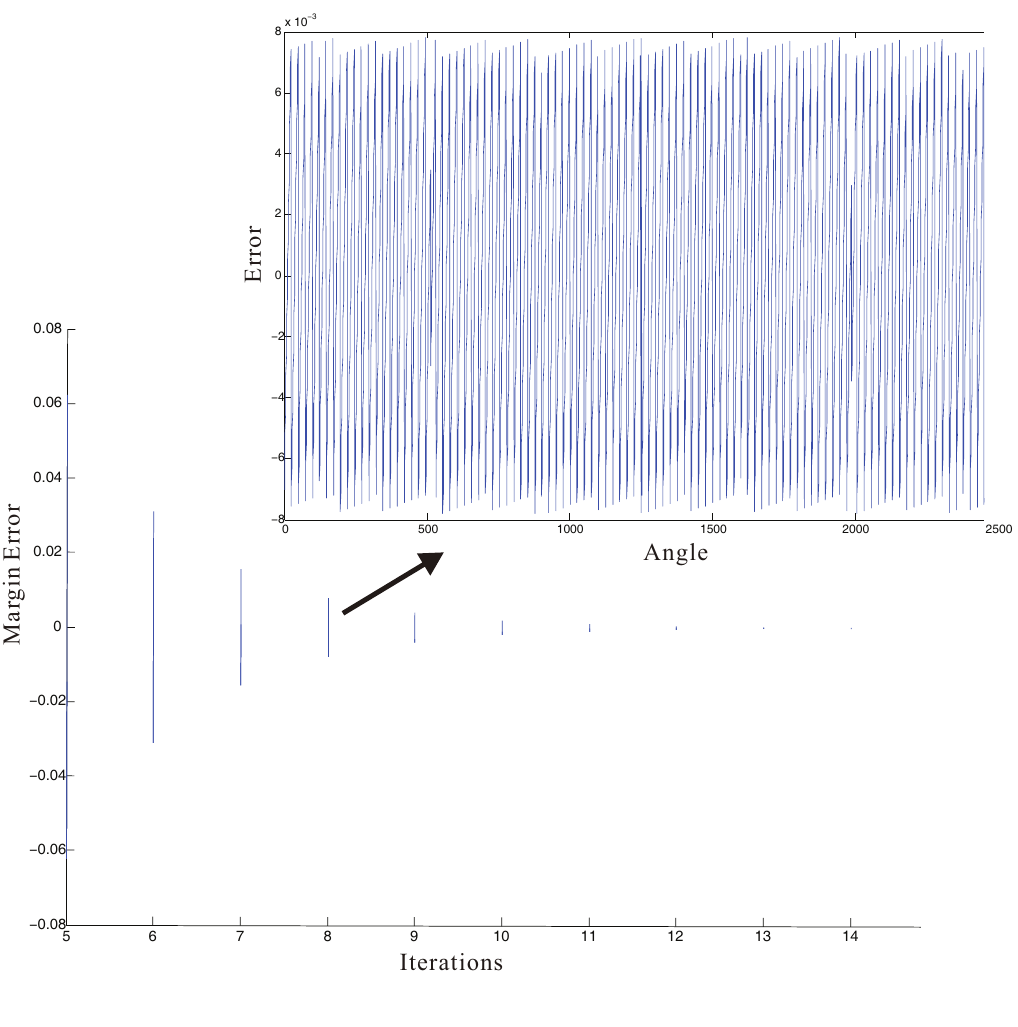
Figure 9. The error in different iterations. The range of the envelope curve decreases with the increase of the iterations. In the CORDIC algorithm, all angles originate from the angle range of 0 ◦ to 90 ◦ . The subgraph displays the error through eight